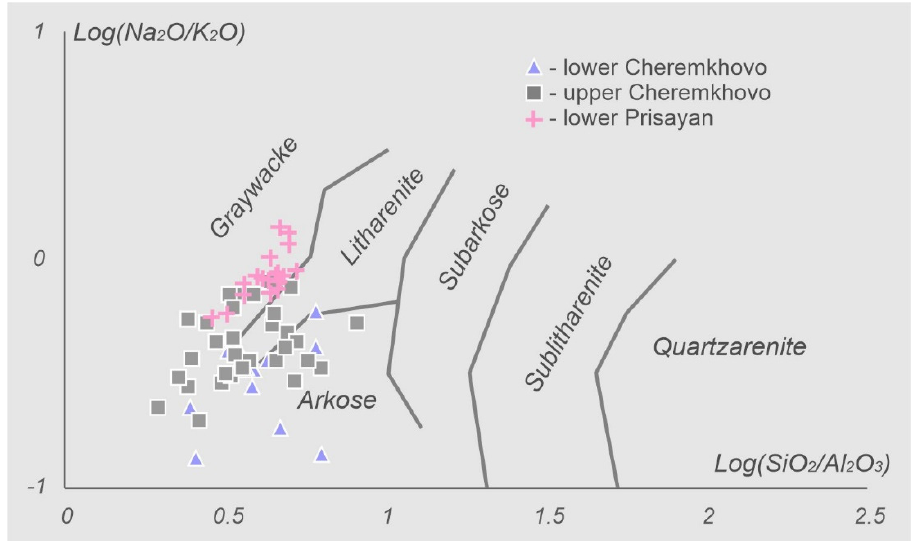
Figure 8. Chemical classification of sandstones in the Irkutsk coal-bearing basin, based on their major element compositions (after [29] ).